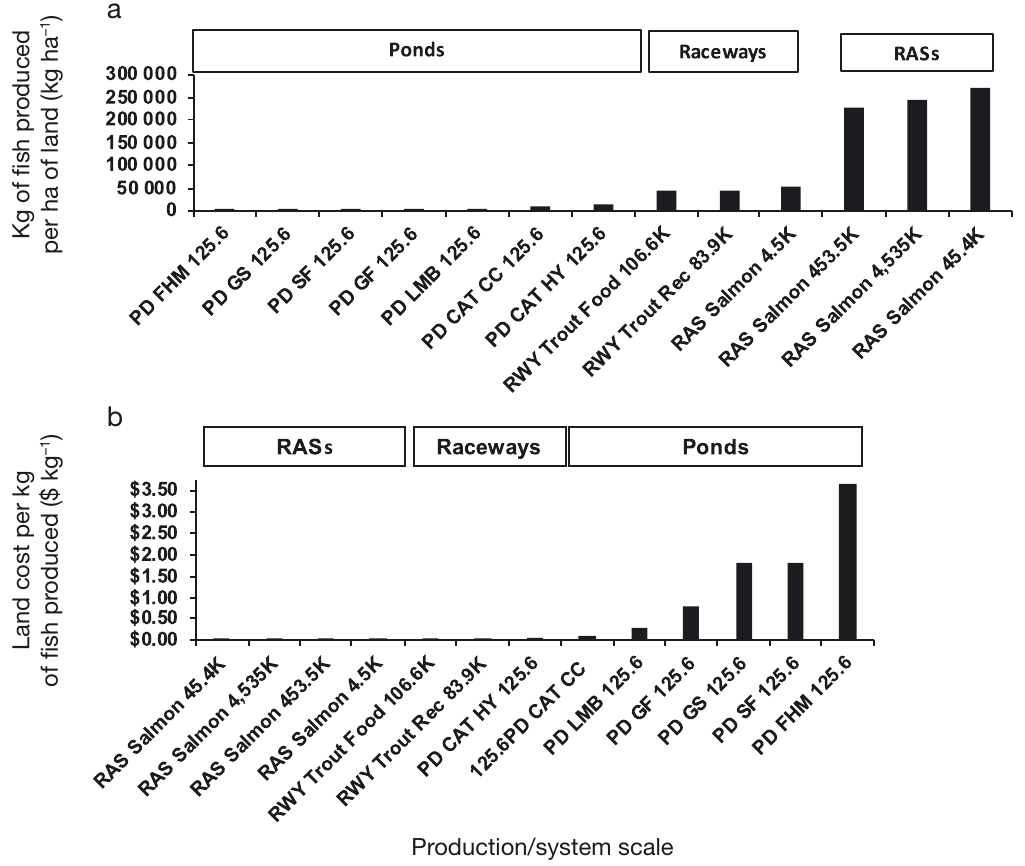
Fig. 1. (a) Productivity of land use and (b) land cost across production systems. In scenarios where production scale did not affect relative rankings, only one production scale is presented. PD: pond; RWY: raceway; RAS: recirculating aquaculture sys- tem; FHM: fathead minnows; GS: golden shiners; SF: sportfish; GF: goldfish; LMB: largemouth bass; CAT CC: channel catfish multiple batch; CAT HY: hybrid catfish intensive aeration; 125.6: pond ha; Trout Food: trout raised for foodfish; Trout Rec: trout raised for recreational market; 106.6K: 106600 kg produced yr −1 ; 83.9K: 83900 kg produced yr –1 ;RAS 4.5K = 4500 kg pro- duced yr −1 ; 45.4K: 45400 kg produced yr −1 ; 453.5K: 453500 kg produced yr −1 ; and 4,535K = 4535000 kg produced yr